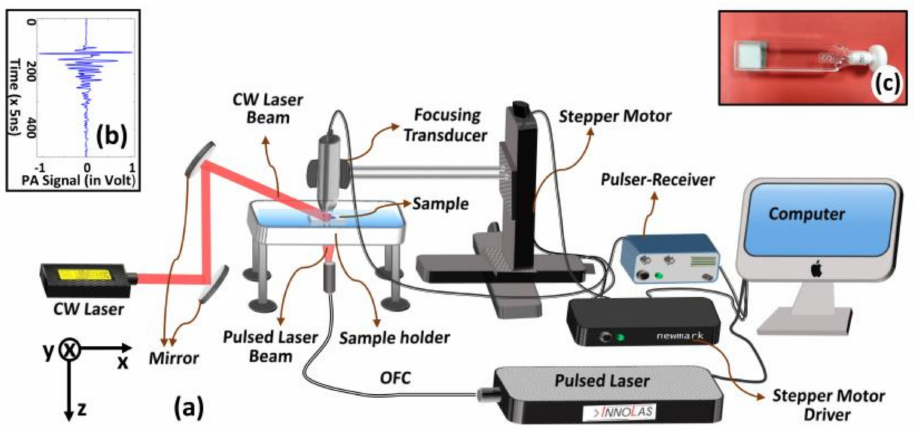
Figure 2. Schematic diagram of the experimental set-up ( a ). A typical 1D PA-signal acquired by our acoustic resolution photoacoustic microscopy (AR-PAM) imaging system ( b ). ( c ) Photograph of transparent cuvette (inner thickness ~1 mm) that is employed as holder for imaging sample (methylene blue